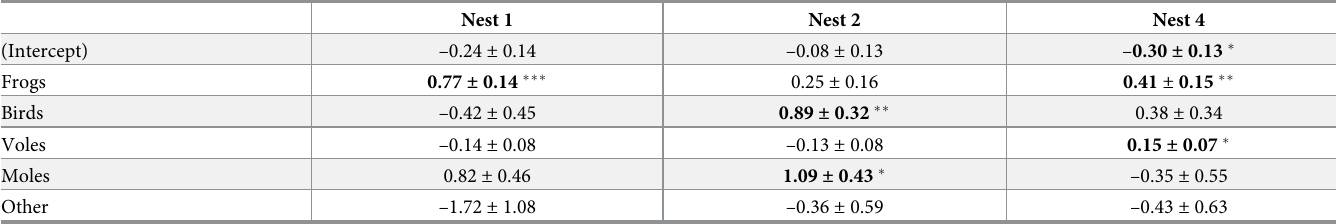
Table 3. Estimates ( ± SE) of multinomial models indicating significant differences among three studied pairs (compared with nest